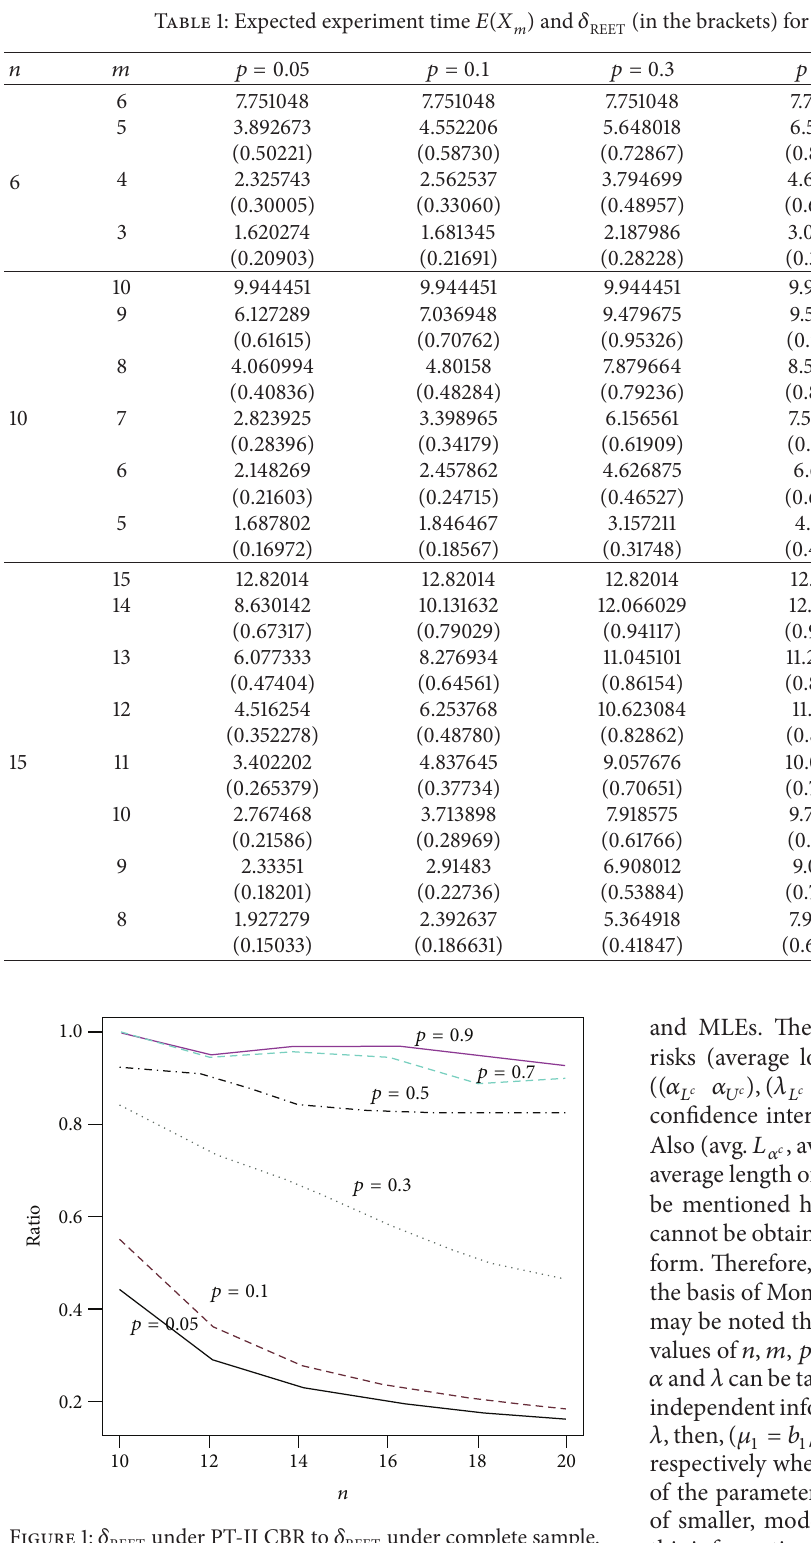
the corresponding Bayes estimators under SELF and GELF, respectively. We compare the estimators obtained under GELF with corresponding Bayes estimators under